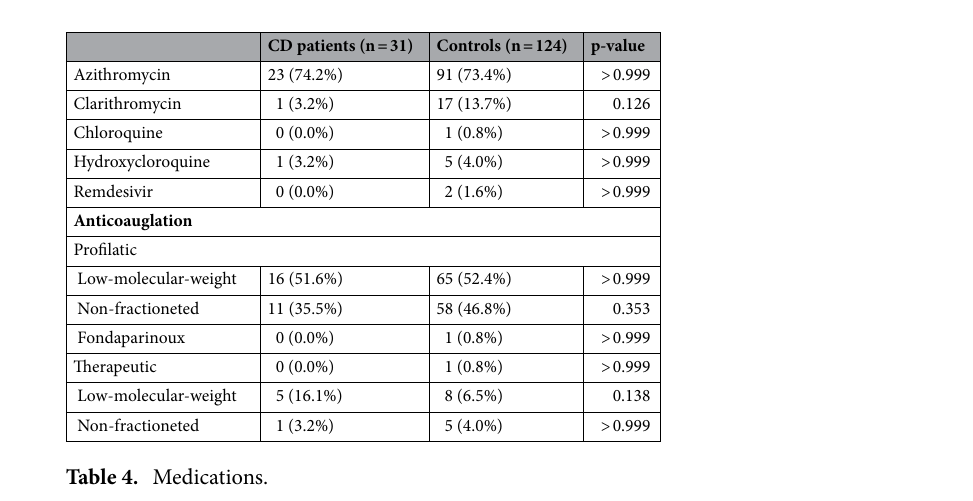
Table 4. Medications.